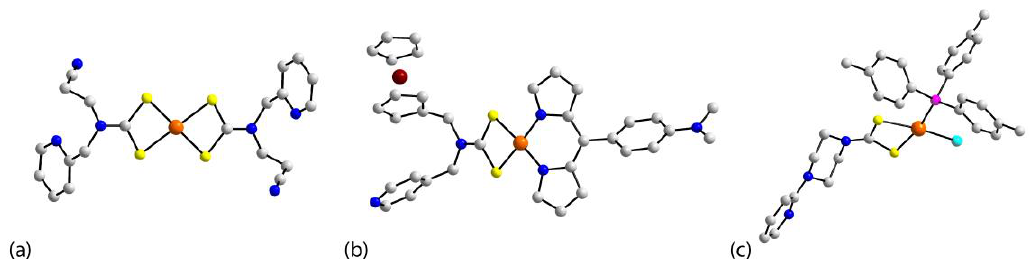
Figure 2. Molecular structures for ( a ) Ni(L 3 ) 2 ( 3 ), ( b ) (NN 1 )Ni(L 5 ) ( 5 ), and ( c ) [(4-tol) 3 P]Pd(L 6 )Cl ( 7 ). Color code in this and subsequent diagrams—the central metal atom is shown in orange; other heavy element, brown; chloride, cyan; sulfur, yellow; phosphorus, purple; nitrogen, blue; and carbon, grey. Generally, hydrogen atoms are omitted for clarity.